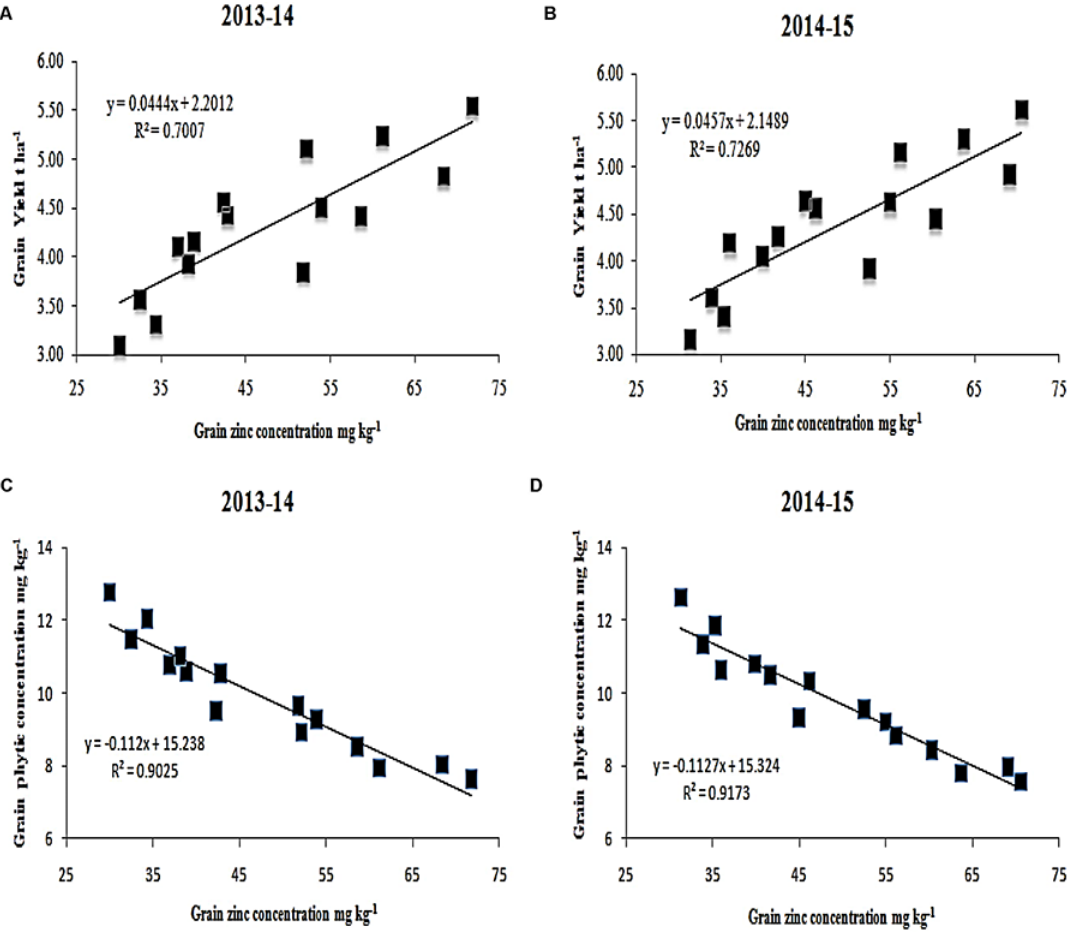
Fig. 3 Two years of study found a significant positive correlation between grain yield and grain Zn of wheat ( A,B ) and grain Zn and phytic acid concentrations ( C,D ) (source: